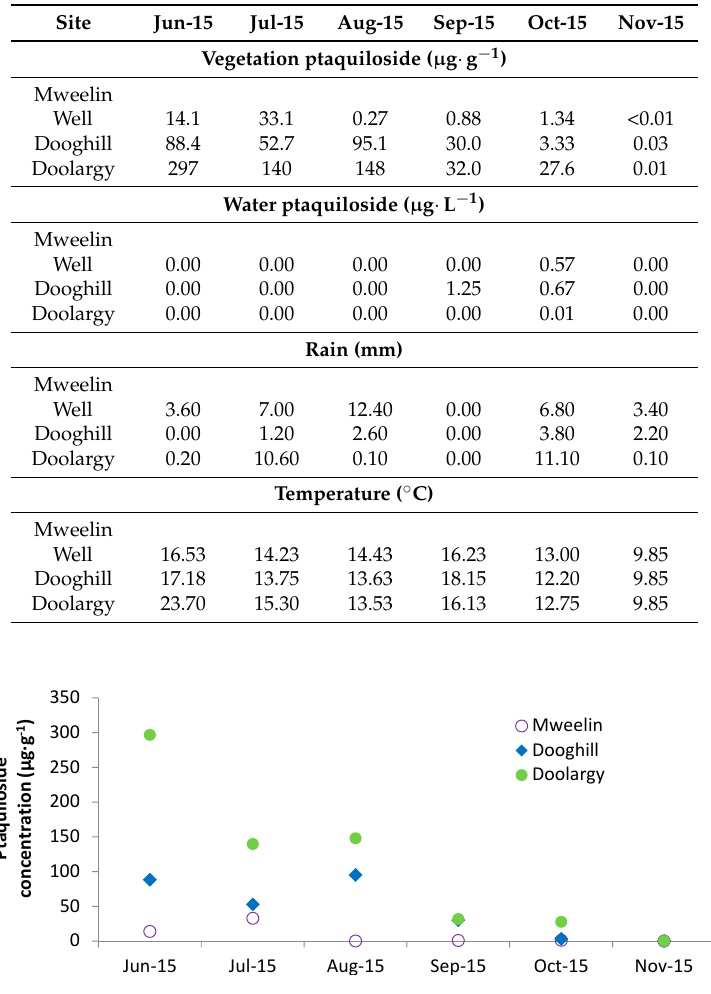
Table 2. Ptaquiloside concentrations ( µ g ¨ g ´ 1 ) in bracken fronds and water samples from the drinking water abstraction sites; and total rainfall (mm) and average temperature ( ˝ C) in the twenty-four hours preceding sample collection taken from Met Eireann rainfall stations adjacent to each of the study sites.